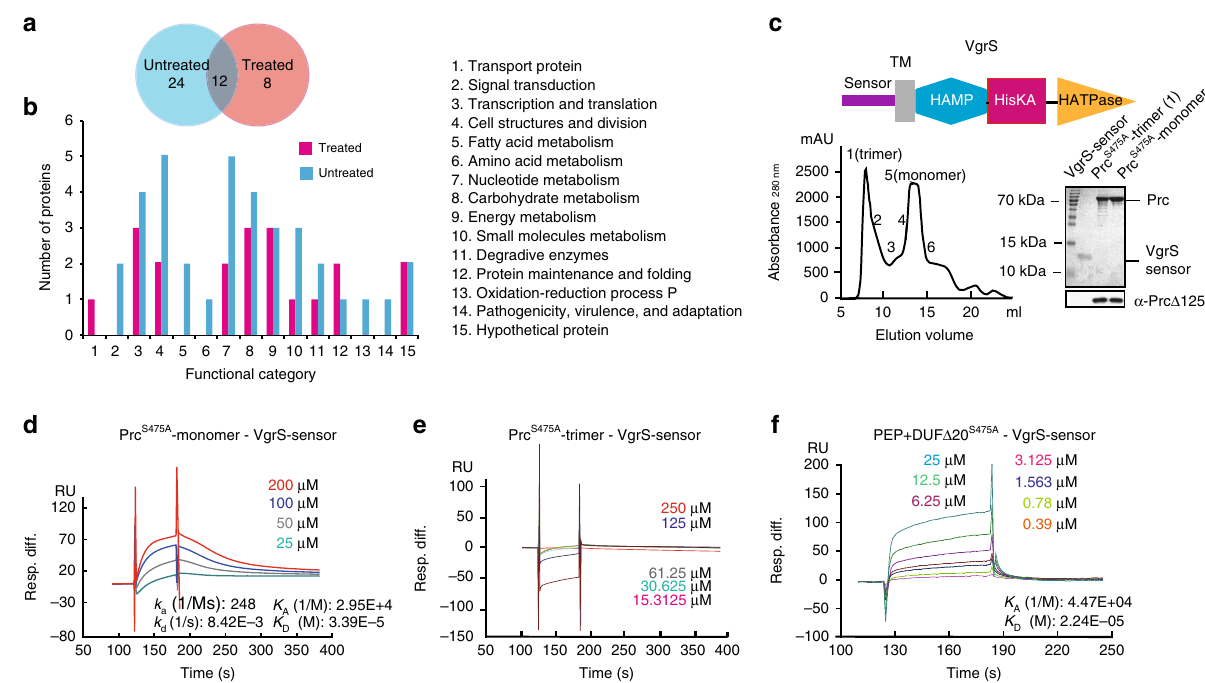
Fig. 3 Tandem af fi nity puri fi cation (TAP) identify that the VgrS sensor directly binds the Prc monomer. a Venn diagram of the number of proteins identi fi ed by TAP together with a nanoLC – MS/MS analysis. Samples subjected or not subjected to osmostress were analysed. b Functional categories of the putative Prc binding proteins. Protein details are listed in Supplementary Table 3. c Prc exists as a monomer and a trimer in vitro. Upper panel: Secondary structure of VgrS. Lower left panel: Recombinant Prc S475A was separated by a molecular sieve, and the molecular weights of the fractions were measured by analytical ultracentrifugation. Lower right panel: Puri fi cation of the VgrS sensor and Prc proteins. Western blotting was used to verify the Prc proteins, as shown below. d – f Quanti fi cation of the binding af fi nity between the VgrS sensor and recombinant Prc by surface plasmon resonance. d The VgrS sensor bound the Prc S475A monomer. e The VgrS sensor did not bind the Prc S475A trimer. f The VgrS sensor bound a truncated Prc S475A , which contains peptidase and DUF3340 domains. The VgrS sensor protein was trapped on a sensor CM5 chip, and various concentrations of Prc were injected at a fl ow-rate of 30 μ l/min at 25 °C. Data were analysed using a model for a single set of identical binding sites. The binding kinetics of the Prc –